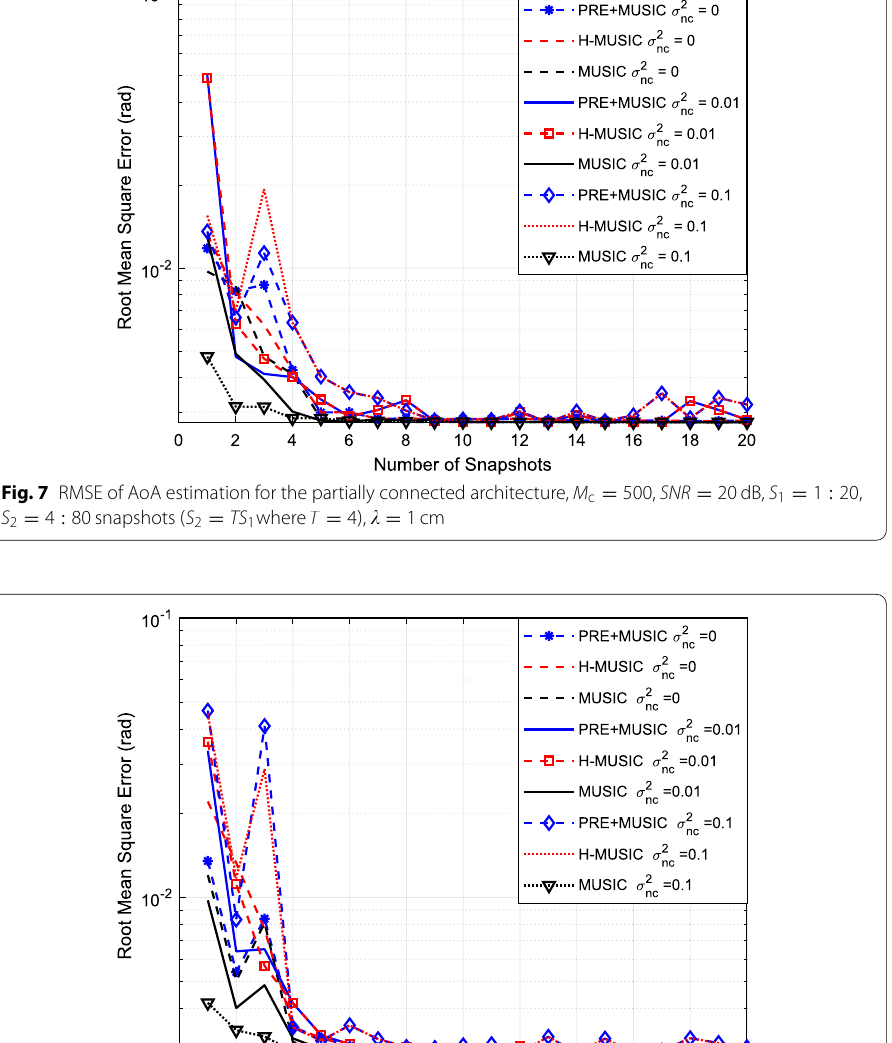
RMSE of the three schemes (i.e., PRE MUSIC, H-MUSIC and MUSIC) versus the SNR + 2 20 80 0, 0.01, 0.1 and S 1 , S 2 , respectively. It can be observed that both for σ nc = { = = }